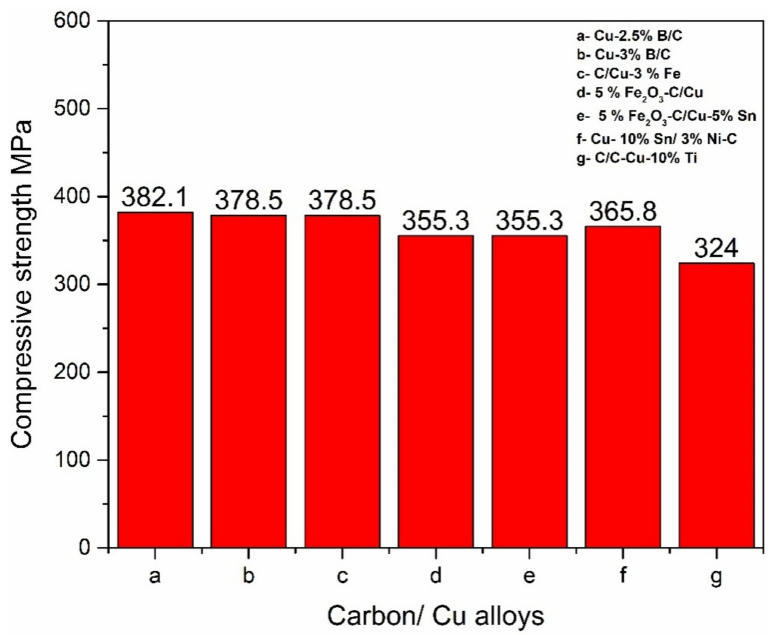
Figure 4. Compressive strength of composites (a: [47]; b: [48]; c: [49]; d: [52]; e: [53]; f: [54]; g: [39]).